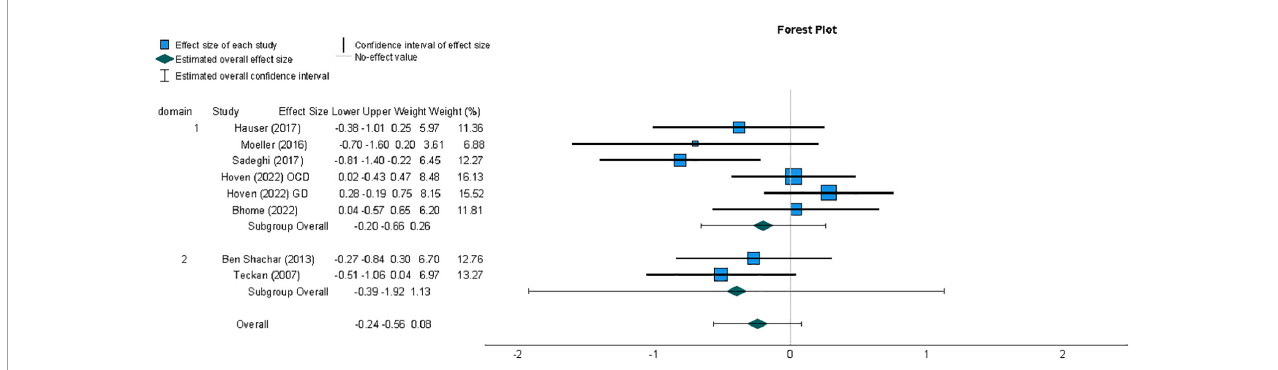
FIGURE5 Forest plot of the distribution of effect sizes for metacognitive sensitivity across studies of samples with non-psychotic symptoms of mental disorder, based on a random-effects analysis, displaying effects by arranged sub-group of task domain, which was either perceptual (1) or non-perceptual (2). Lower metacognitive sensitivity in those with non-psychotic symptoms of mental disorder is indicated by a negative effect size. The summary effect size is indicated by a diamond marker, underneath the individual study effect